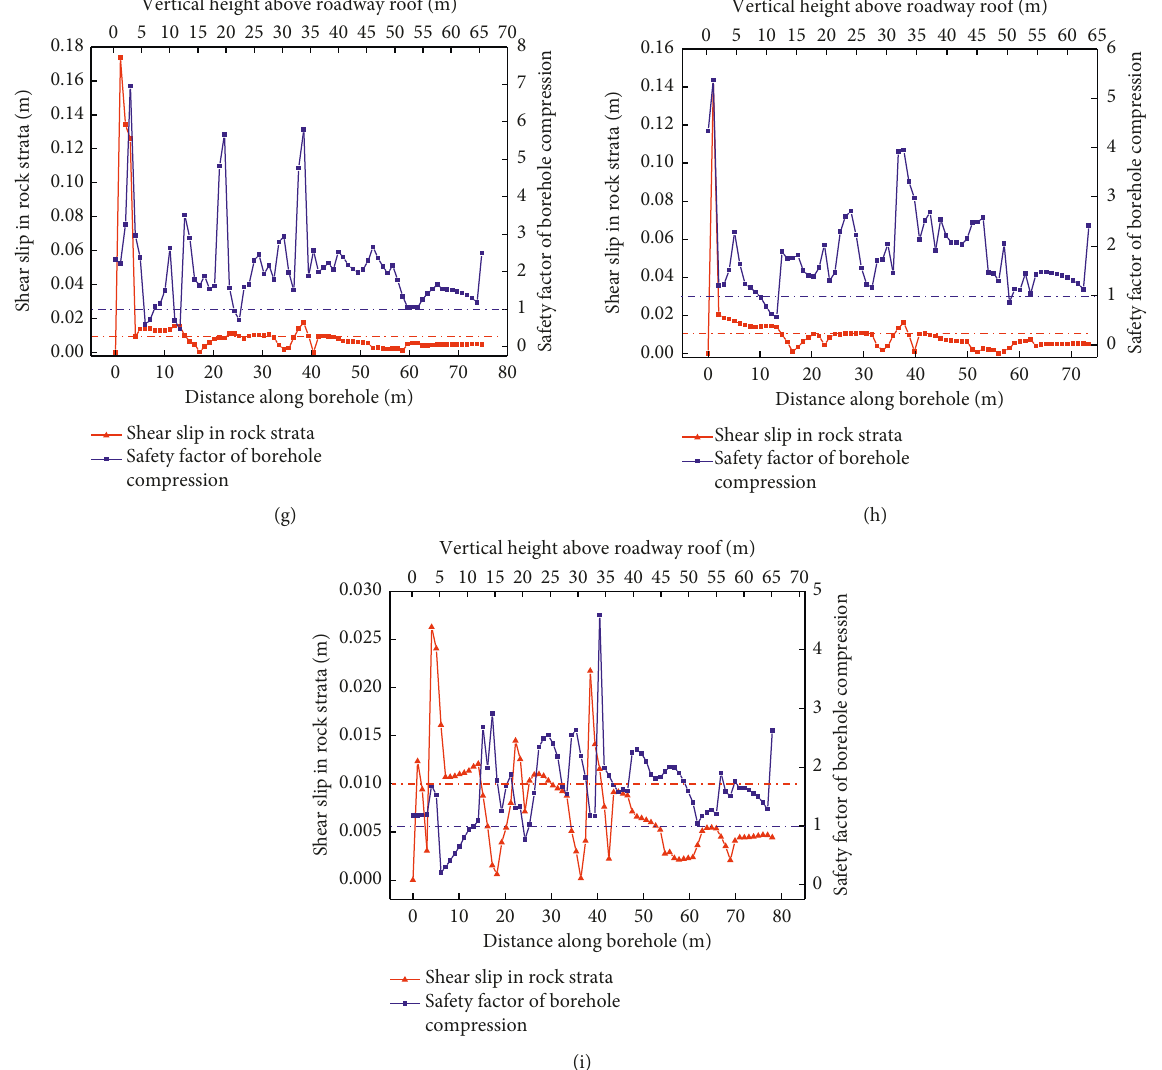
Figure 10: Distribution law for shear-slippage value and compressional safety factor in the 1 through 9# drilling paths. (a) 1# drilling path, (b) 2# drilling path, (c) 3# drilling path, (d) 4# drilling path, (e) 5# drilling path, (f) 6# drilling path, (g) 7# drilling path, (h) 8# drilling path, and (i) 9# drilling